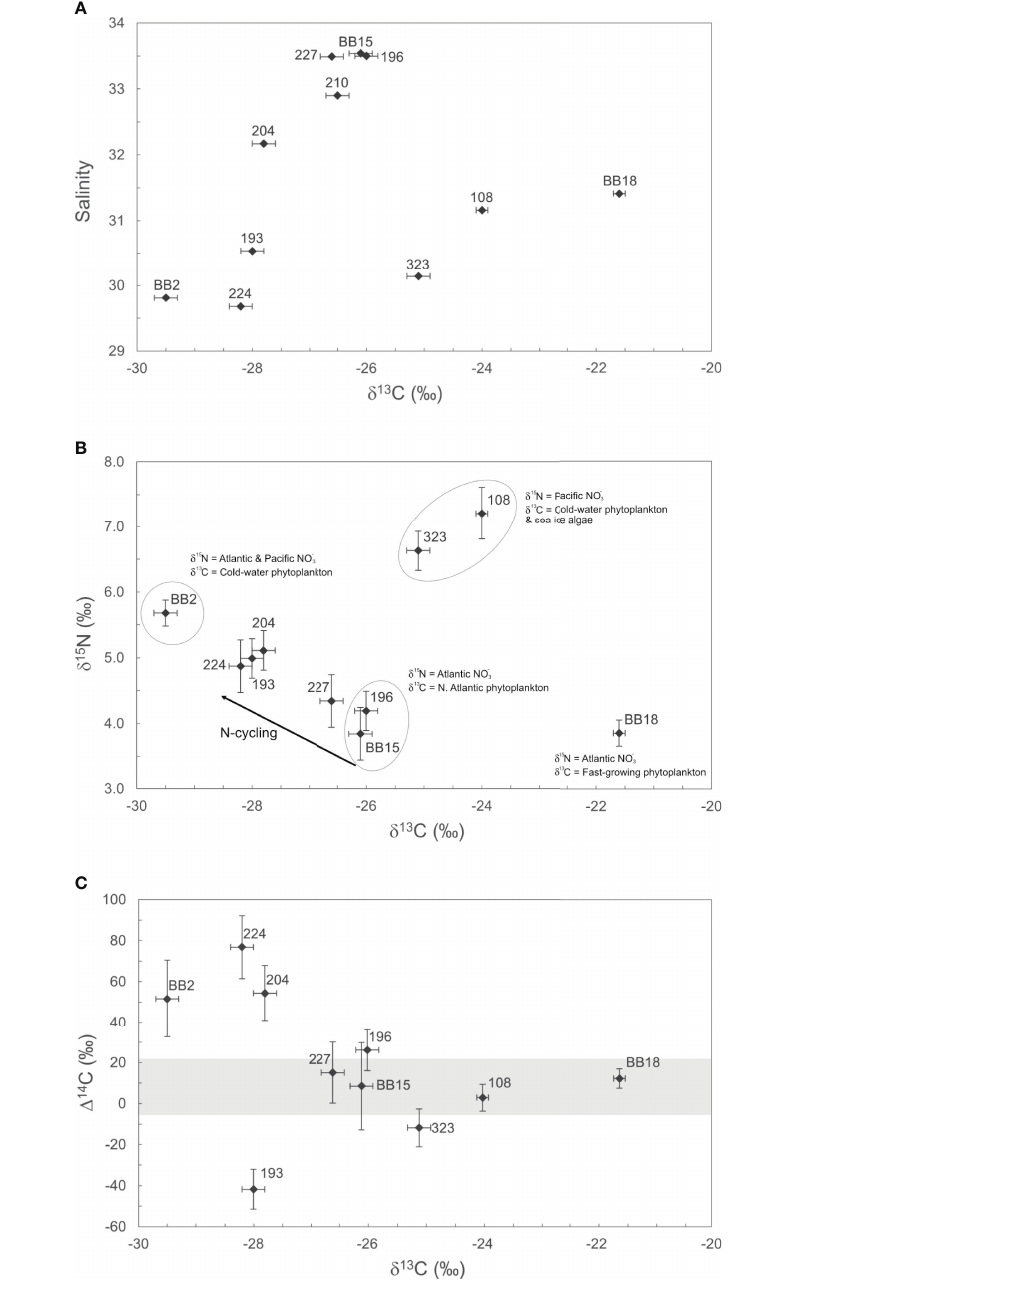
FIGURE 3 | Isotopic ( d 13 C, d 15 N, D 14 C) composition of POM in Baf fi n Bay. (A) The relationship between POM d 13 C values ( ‰ ) and Salinity (PSU) is shown. Salinity is used here to highlight differences in POM sources via water mass origin. (B) The stable isotopic ( d 13 C, d 15 N) composition of POM is shown, with observed isotopic endmembers. (C) the distribution of POM D 14 C and d 13 C values is shown. The horizontal grey bar represents the full range in measured DIC D 14 C values for Baf fi n Bay (Zeidan et al., 2022). For all plots, isotope valued errors ( ± 1 s ) are listed in Table 1